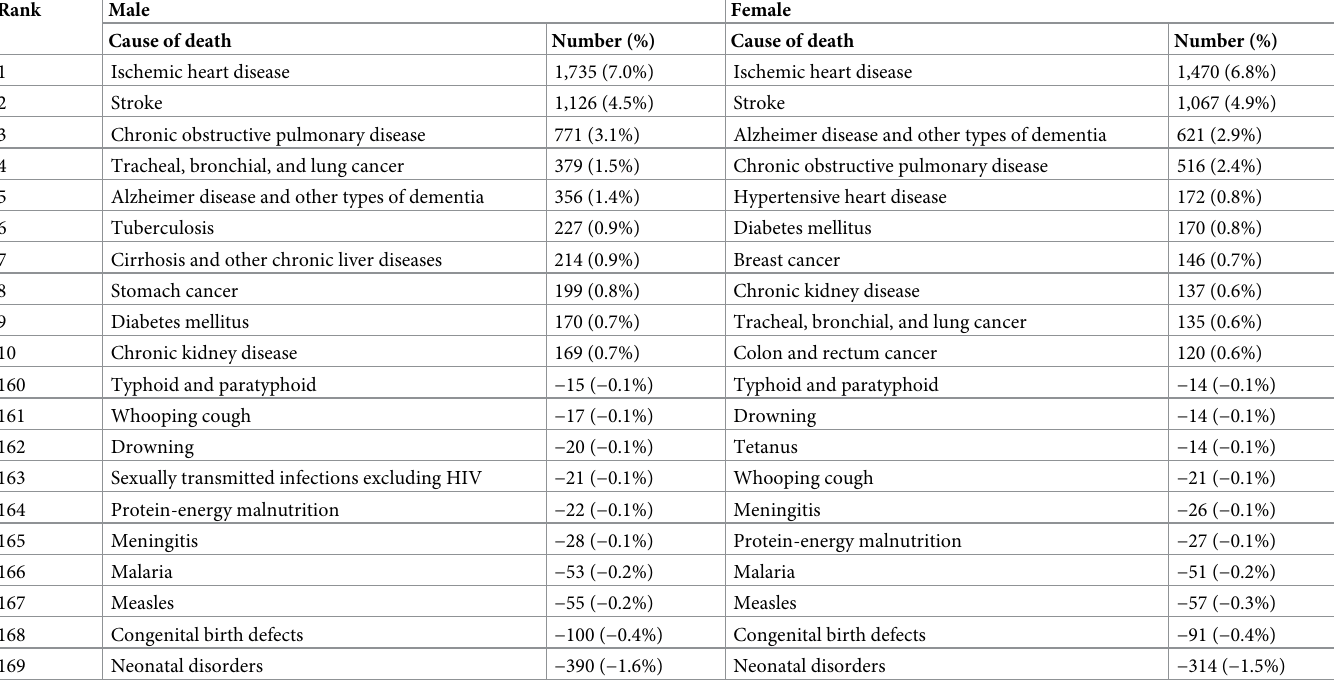
The attributed proportion for males was calculated as the number of deaths attributed to population ageing for each cause of death/24.9 million (total male deaths in 1990) × 100%. The attributed proportion for females was calculated as the number of deaths attributed to population ageing for each cause of death/21.6 million (total female deaths in 1990) ×